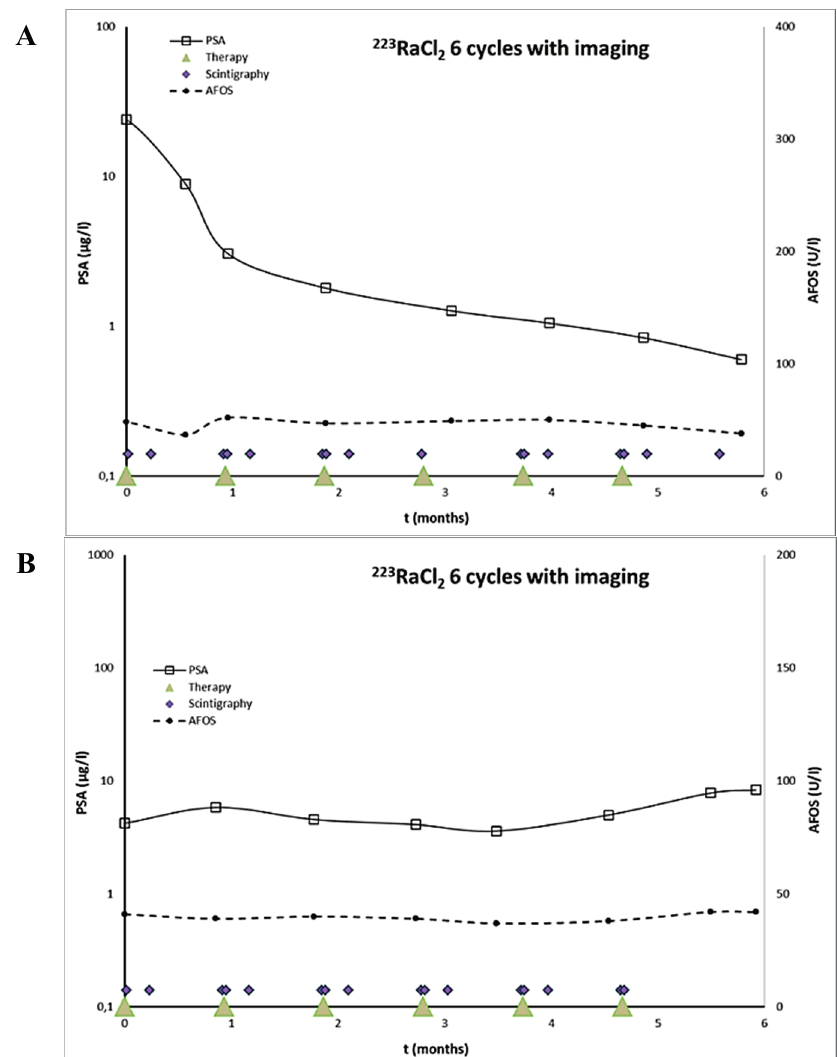
Figure 1. 223 RaCl 2 therapeutic dosing schedule and timing of serial gamma camera imagings. S-PSA and S-AFOS oncentrations are presented as well. The patient 1 ( A ) demonstrated a S-PSA response, whereas the patient 2 ( B ) had an increasing S-PSA concentration. S-AFOS was almost unchanged in both patients during 223 RaCl 2 treatment